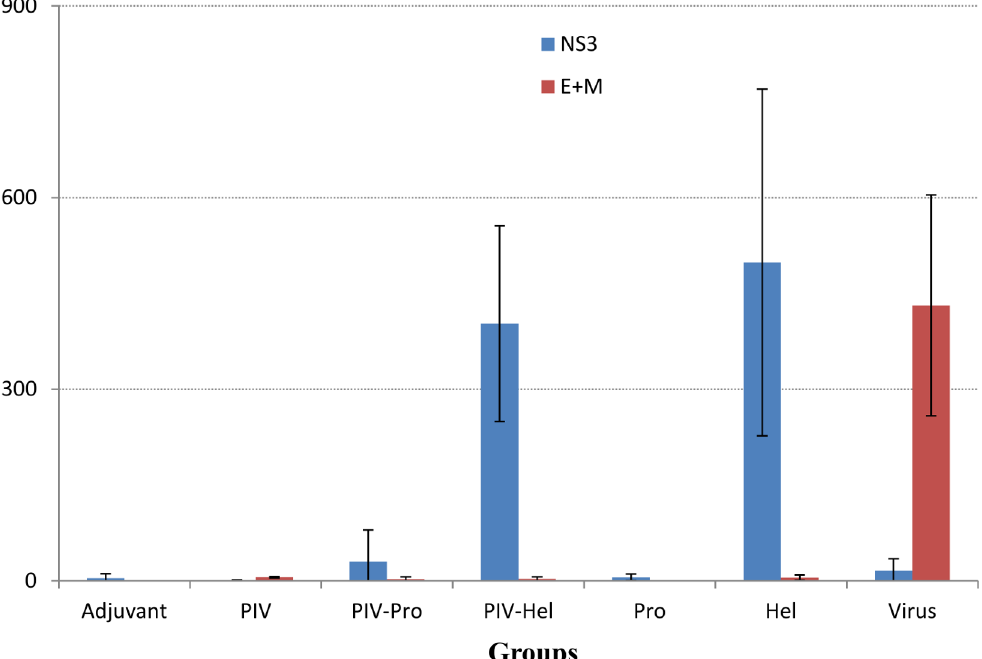
Fig 5. T-cell responses induced by vaccination with recombinant protein. Groups of vaccinated mice were tested for IFN- γ responses using a standard ELISPOT assay. Mouse spleen cells collected on Day 35 after first immunization, were stimulated with overlapping peptide pools spanning the entire M, E and NS3 protein. Responses are presented as number of spots per one million cells. Results indicate the mean of 3 mice with error bars equal to one standard deviation. PIV = purified inactivated vaccine, Pro = protease, Hel = helicase, E = envelope, M = membrane.